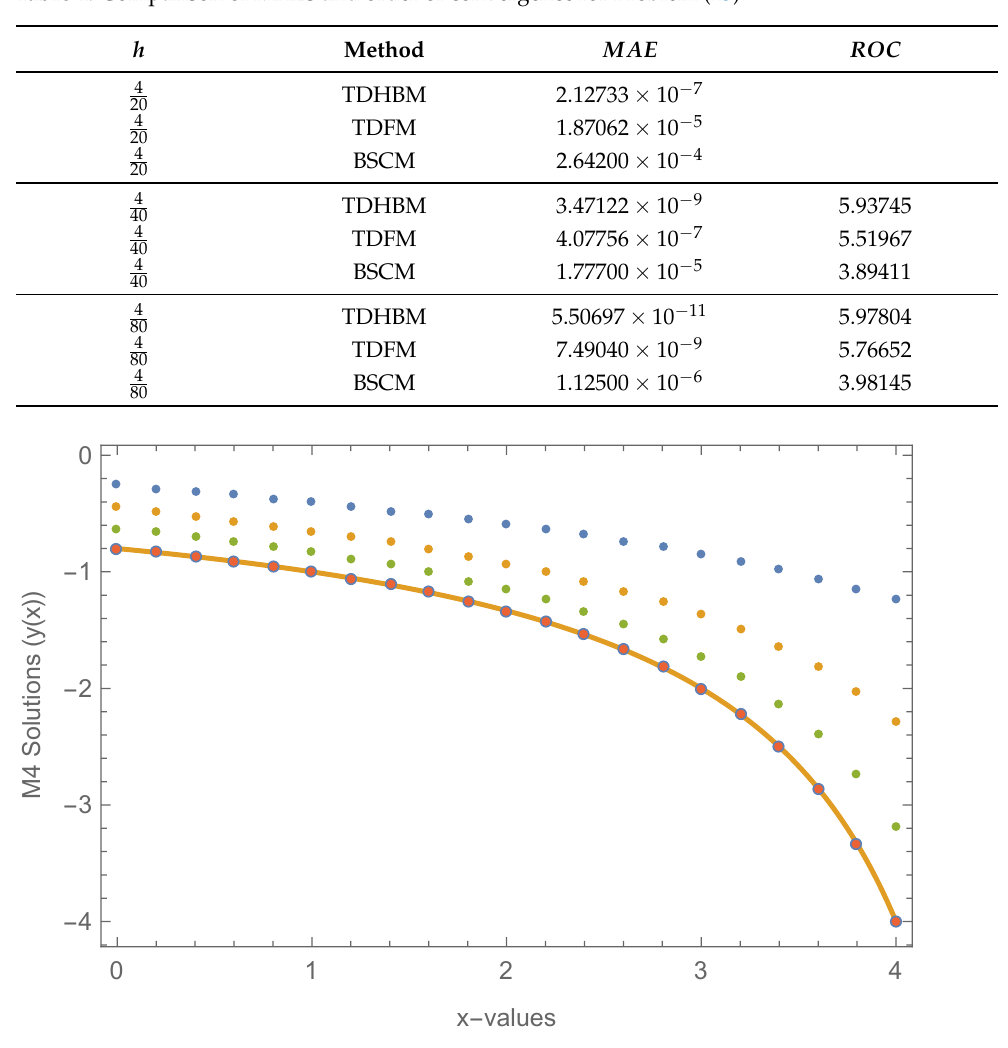
Figure 2. Exact and discrete solutions with the method TDHBM on Problem (23) with h = 4